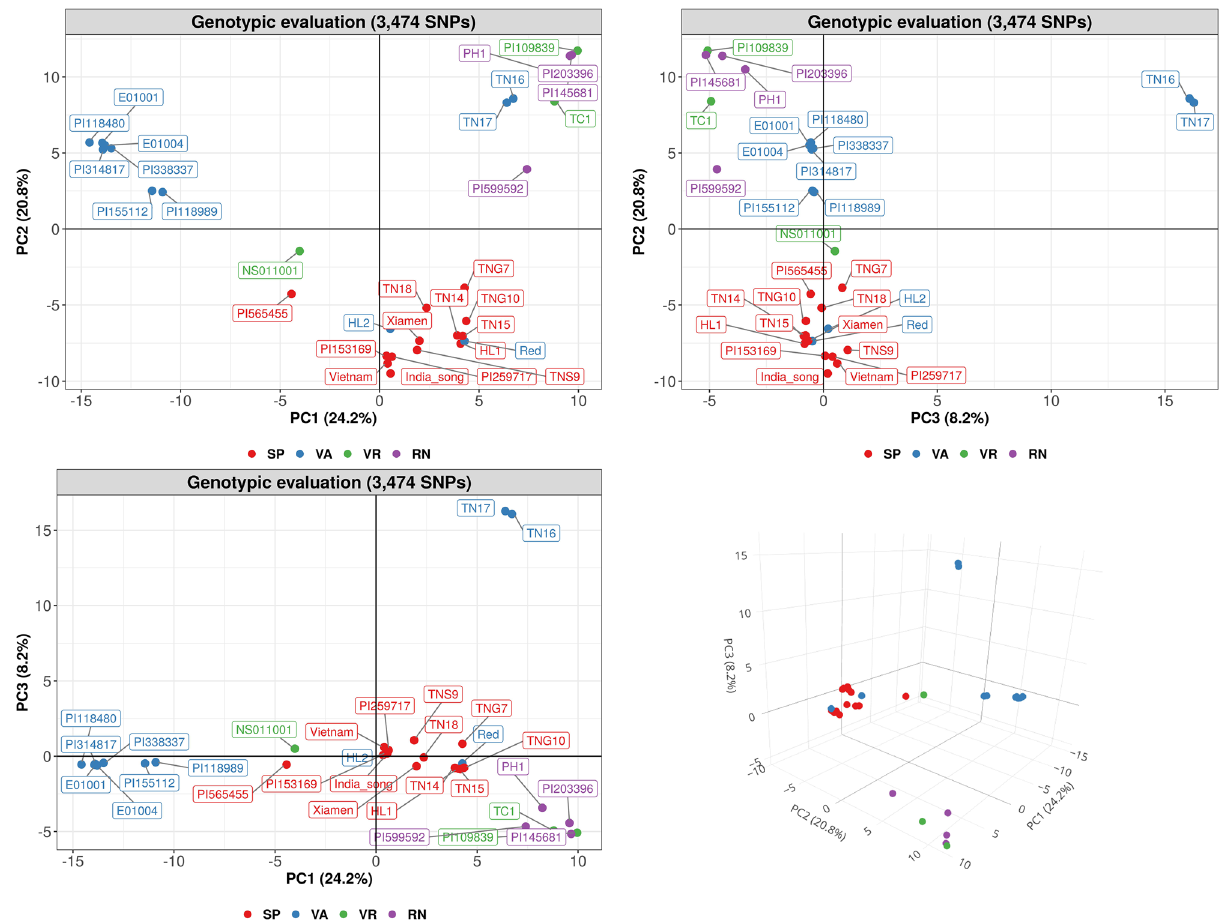
Figure 2. Principal component analysis (PCA) of the 31 accessions based on 3474 single nucleotide polymorphisms (SNPs). The 31 accessions were visualized by 4 market types, Spanish (SP), Valencia (VA), Virginia (VR), Runner